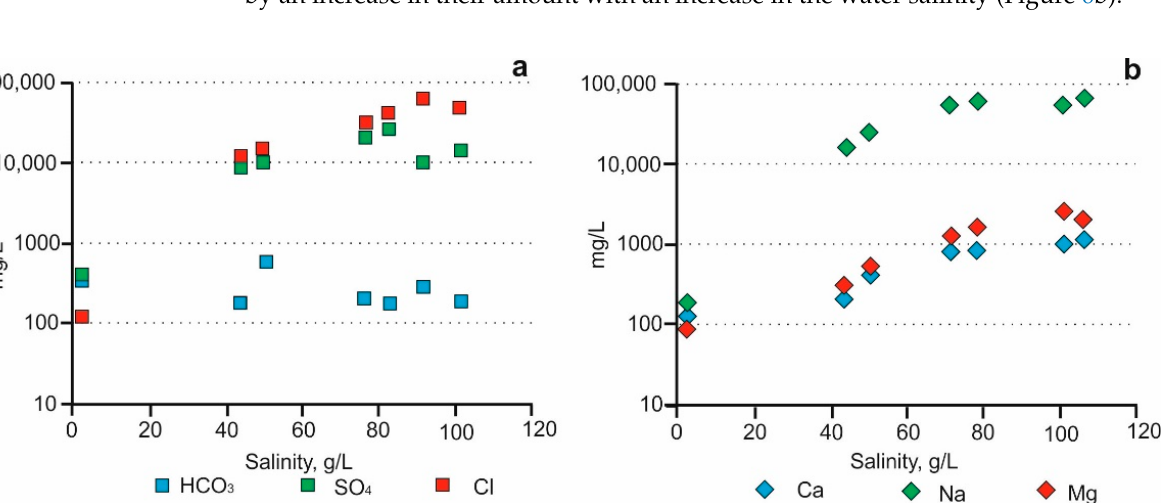
Figure 6. Dependence of basic anions ( a ) and cations ( b ) on water mineralization.